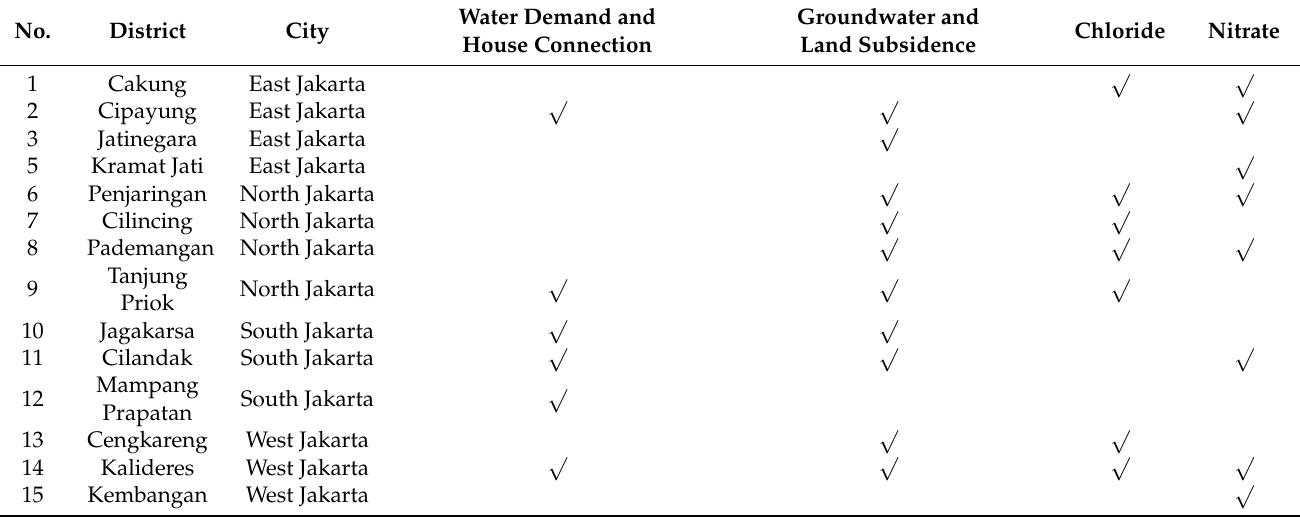
Table A2. Summary of issues for piped water